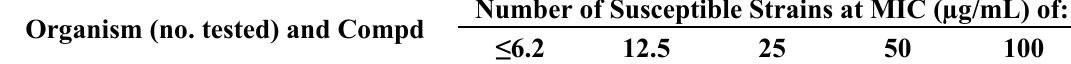
Table 3. Compounds having similar or higher activity than